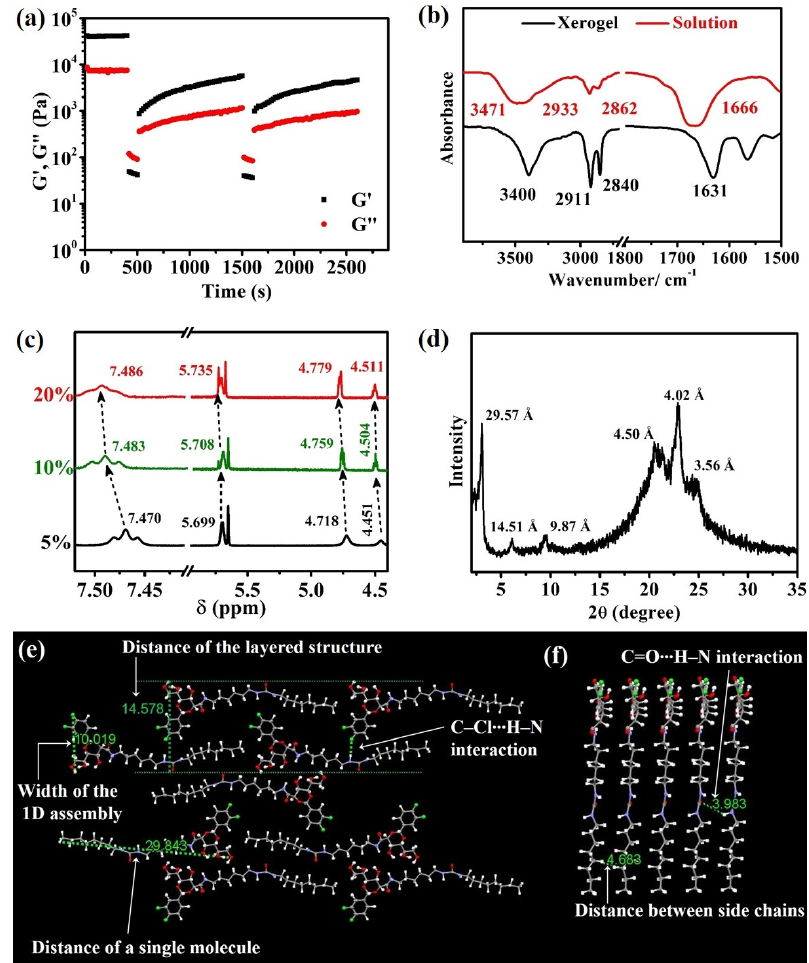
Figure 1 . ( a ) Step-strain measurements of the B8-BMPTFSI ionogel (2%, w/v) over 2 cycles (with an alternating strain of 0.05 and 100% with 1 Hz at 25 °C); ( b ) FT-IR spectra of the B8 xerogel and DMF solution of B8; ( c ) changes in the 1 H NMR shift of N-H and different O-H groups of B8 in BMPTFSI/DMSO-d 6 at ratios (v/v) of 40:60 with the increase in the B8 concentration from 5% (w/v) to 20% (w/v); ( d ) XRD diffraction pattern of the B8-BMPTFSI ionogel (2%, w/v). The optimized self-assembly mode of B8 obtained by theoretical calculations (Gaussian 09 B3LYP method): ( e ) The length of the B8 molecule and the distance of a layered structure of B8, the width of the 1D assembly of B8, and the C-Cl ‧‧‧ H-N H-bonding interaction between B8 molecules; ( f ) the distance between the side chains of A8, the C=O…H-N interaction between A8 molecules. Color code: C = gray; H = white; O = red; N = blue; Cl = green.